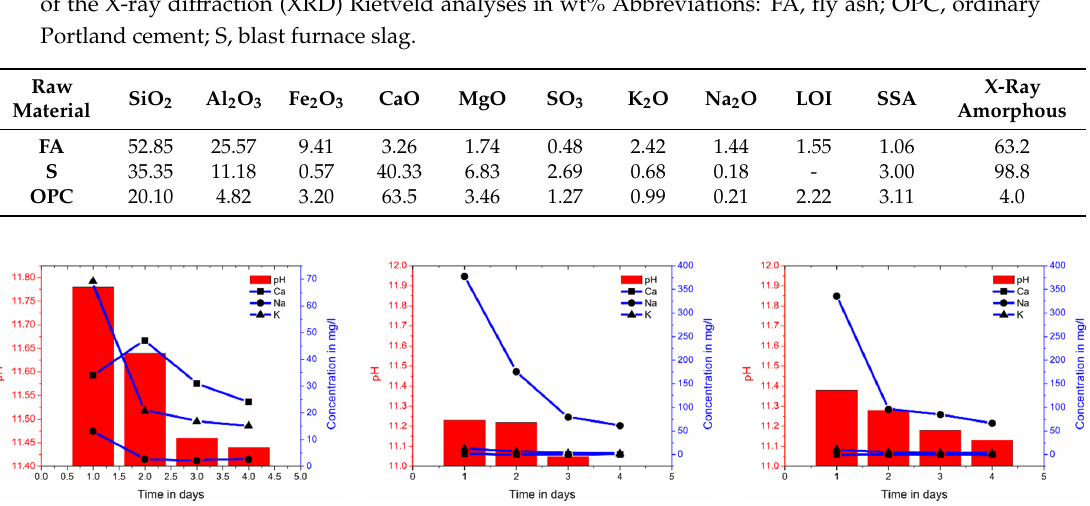
Figure 12. Changes in chemical composition and pH of water in which the leaching samples were stored: OPC ( left ), AAFA ( middle ), AAFAS ( right ).